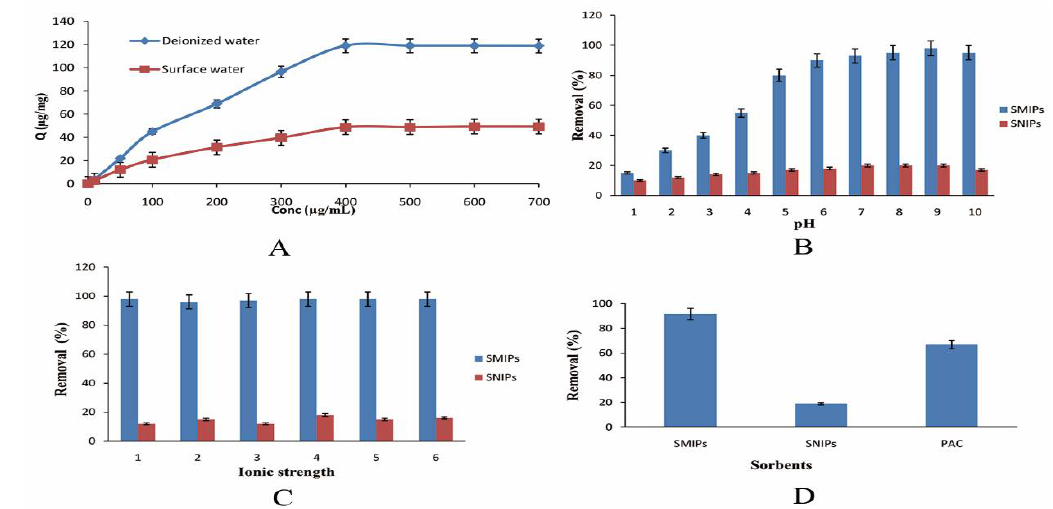
Figure 2. Removal of GSF. ( A ): Removal efficiency in surface and deionized water; ( B ): effect of pH on removal efficiency; ( C ): effect of ionization on removal efficiency; ( D ): comparison of different sorbent materials.